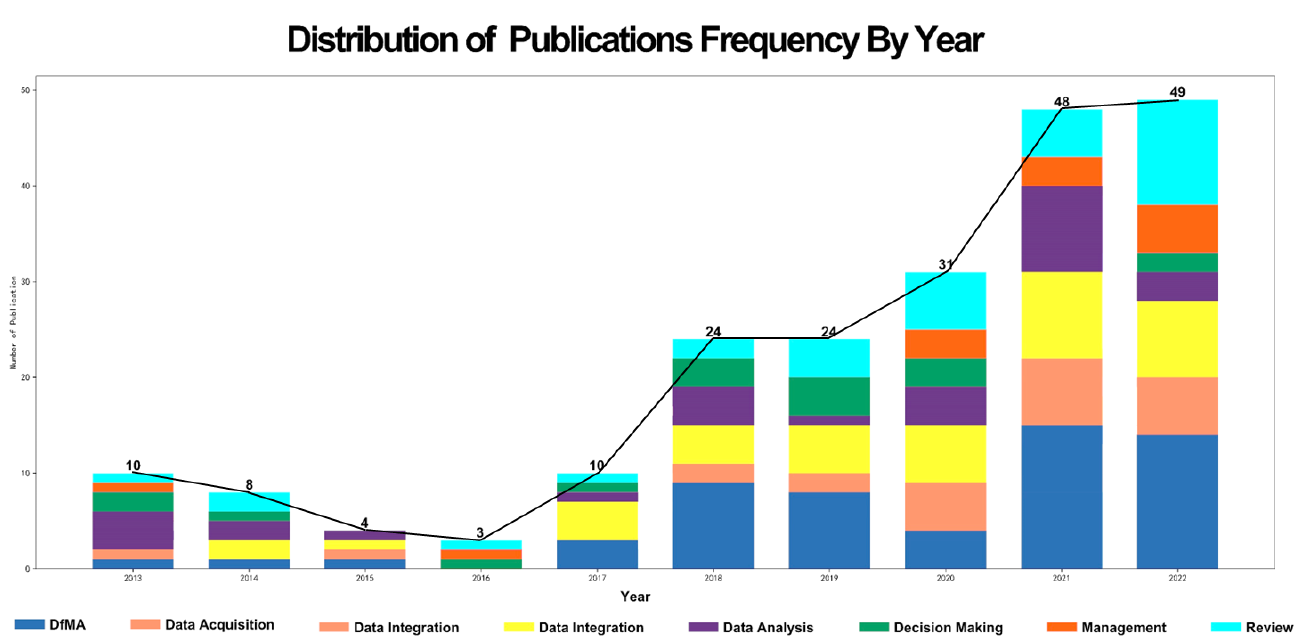
Figure 7. Distribution of publication frequency by year.